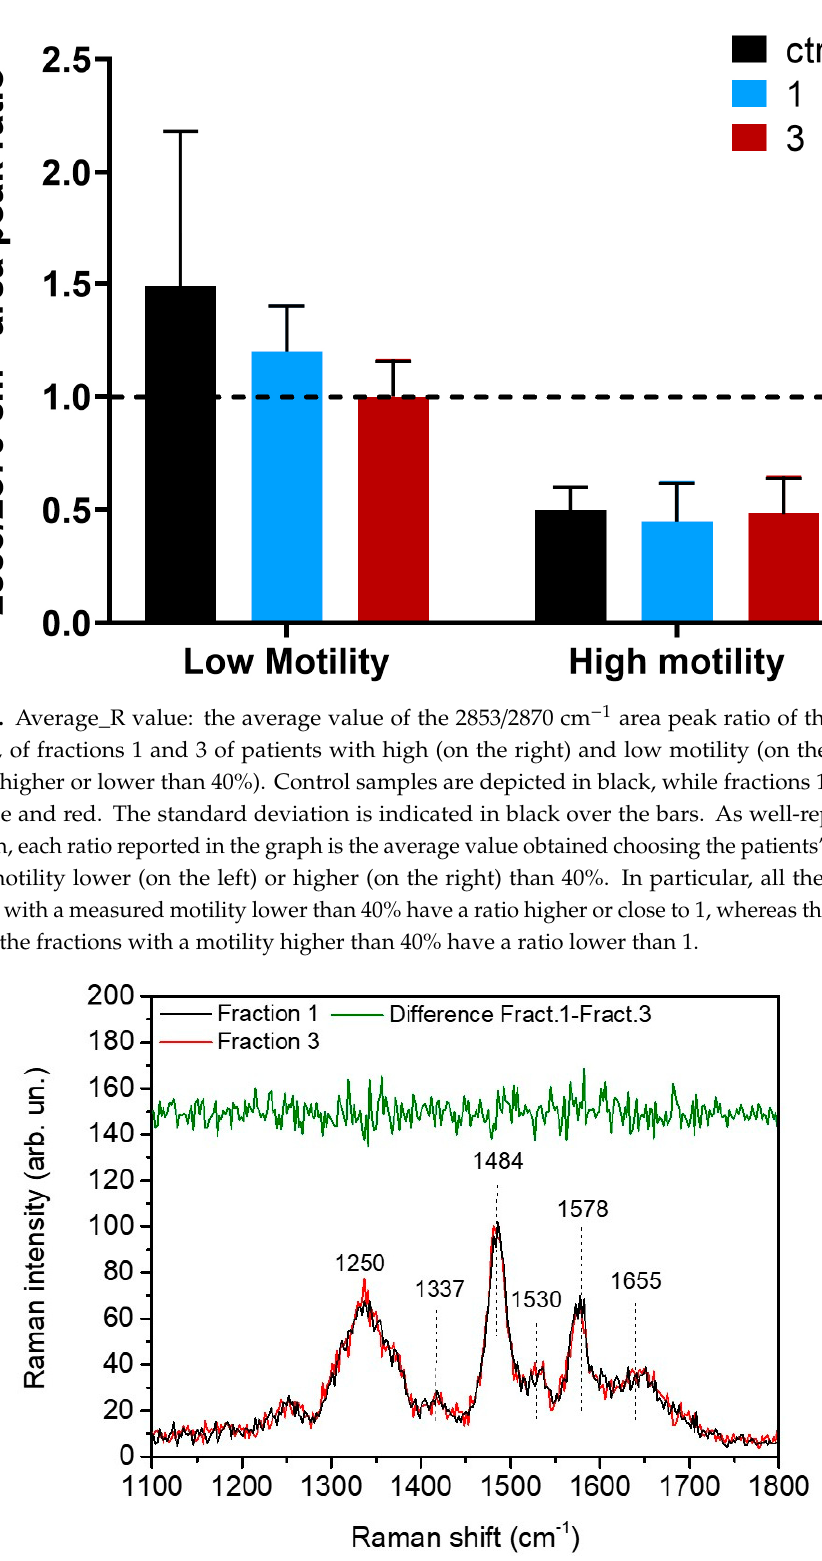
Figure 7. UVRR: UVRR spectra of fraction 1 (black line) and 3 (red line) of patient 3 in the region 1100–1800 cm − 1 . Dashed lines indicate the main peak characterizing the spectra. No significant spectral modifications are visible at nitrogenous bases level. Green line represents the difference spectrum between fraction 1 and 3, highlighting no remarkable difference in DNA damage between capacitated and non-capacitated sample.